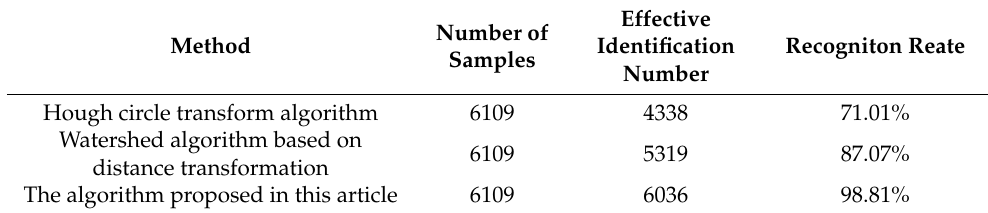
Table 1. Comparison of different methods for segmentation and identification of overlapping Agaricus bisporus